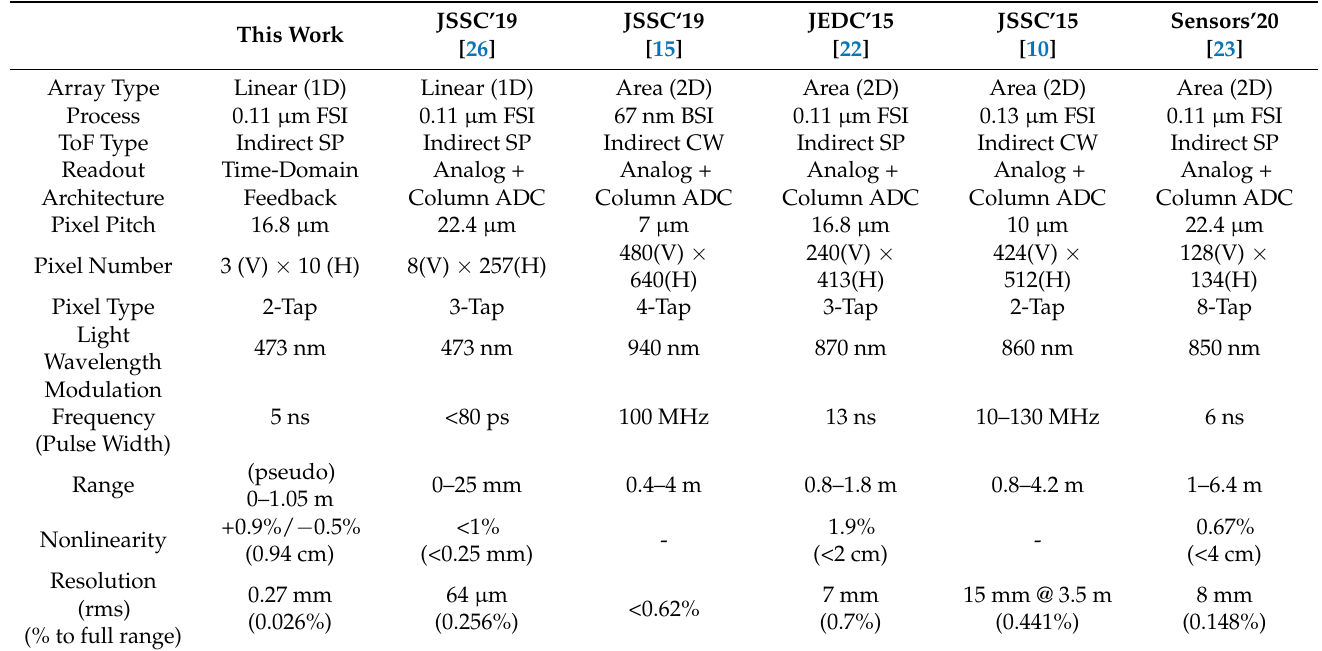
Table 1. Performance summary and